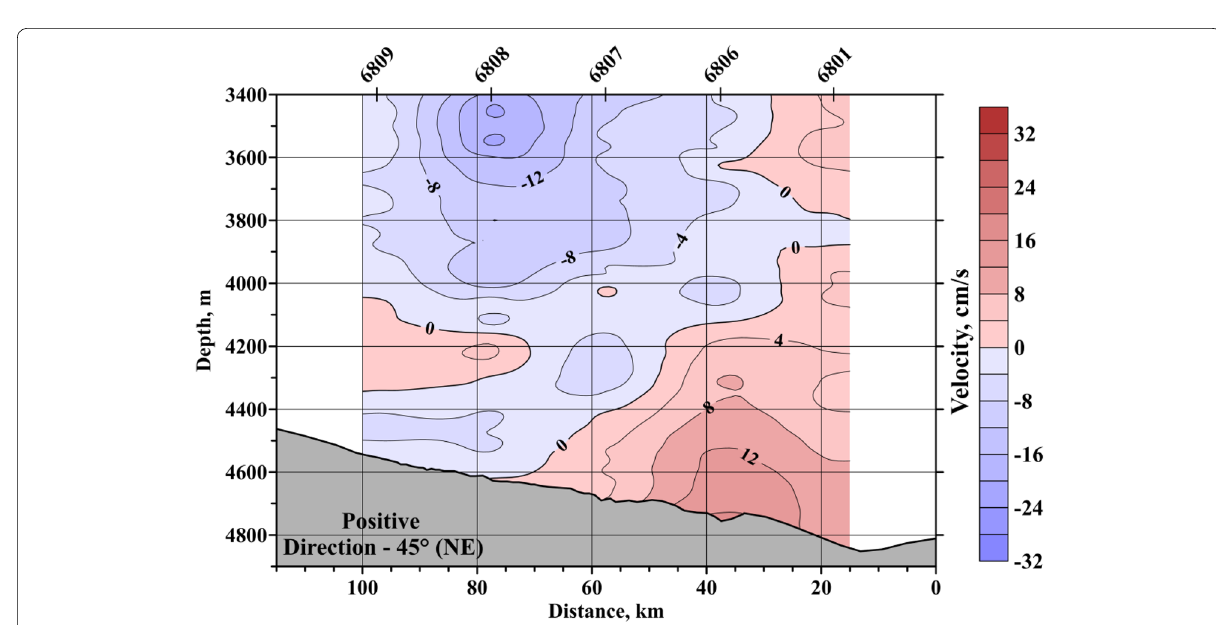
Fig. 8 Section 4 (Fig. 1) of velocity north of the Vema